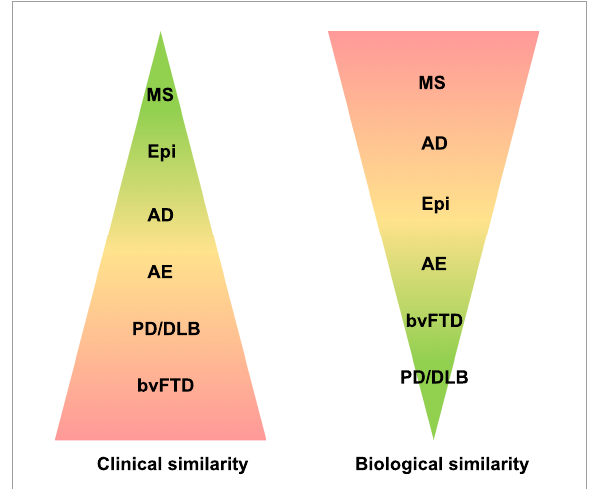
FIGURE2 Neurological disorders of the central nervous system are here classified according to clinical and biological similarity to bipolar spectrum disorders (BSDs). Color coding and the corresponding area indicate the size of similarity. AD, Alzheimer’s disease; AE, autoimmune encephalitis; bvFTD, behavioral variant of frontotemporal dementia; Epi, epilepsy; MS, multiple sclerosis; PD/DLB, Parkinson’s disease, dementia with Lewy